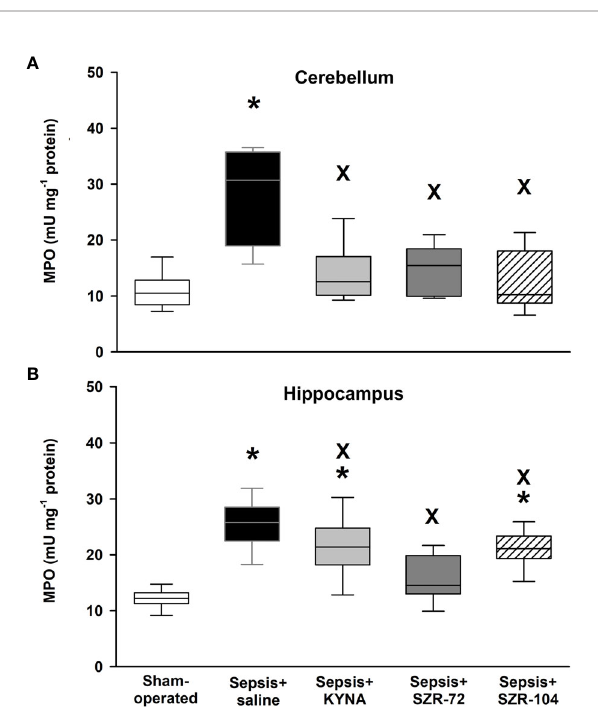
FIGURE 4 | Plasma IL-1 b (A) , citrullinated histone H3 (CitH3, B ) and myeloperoxidase levels (MPO, C ) in a sham-operated group and in different sepsis groups treated with saline, KYNA, SZR-72 and SZR-104. The plots demonstrate the median (horizontal line in the box) and the 25 th (lower whisker) and 75 th (upper whisker) percentiles. (A) Kruskal – Wallis test, Dunn ’ s post-hoc test; (B, C) One-way ANOVA, Holm – Sidak post-hoc test; * P < 0.05 vs . sham-operated group; x P < 0.05 vs . sepsis+saline group.